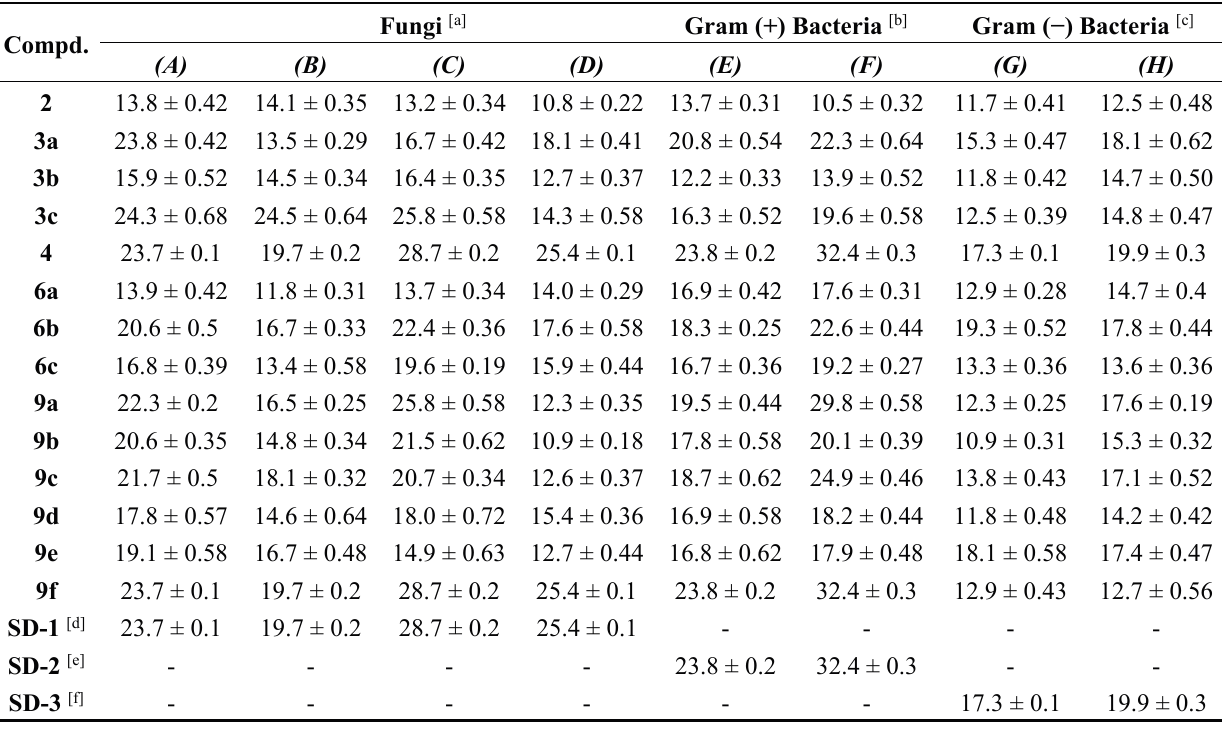
Table 4. Antibacterial and antifungal activity of synthesized compound (zone of inhibition in diameter in